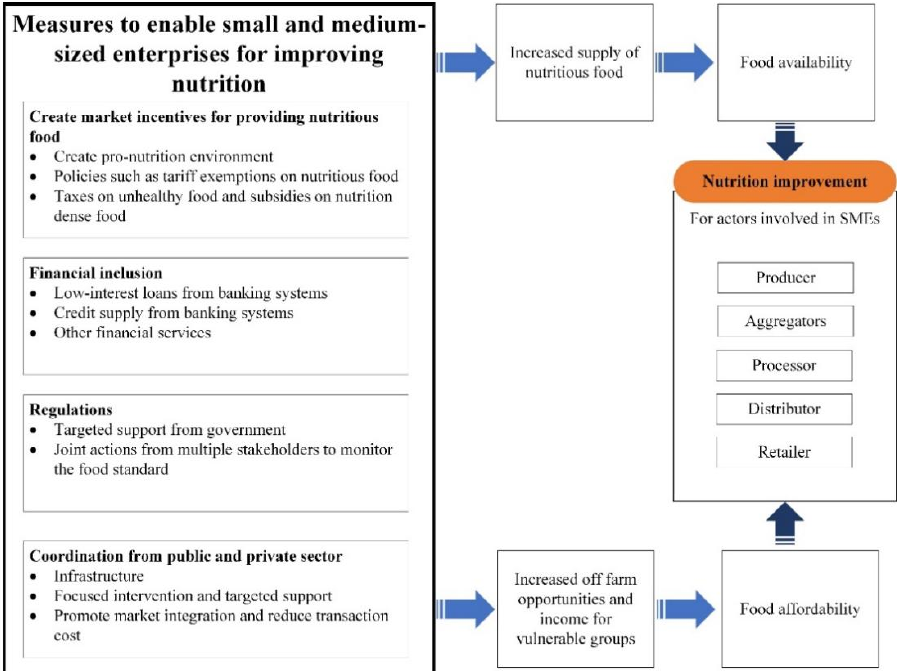
Figure 3. Enabling small- and medium-sized enterprises to improve nutrition.